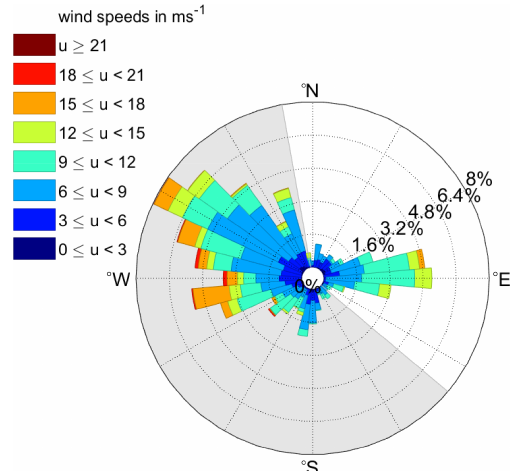
Figure 6. Wind speed and direction distribution of the used data set at the wind farm Global Tech I. Shown are mean wind speed and direction values for all lidar scans with a data availability of at least 80% within the period from 8 March to 31 May 2019. The grey shaded area indicates wind directions that were considered for further